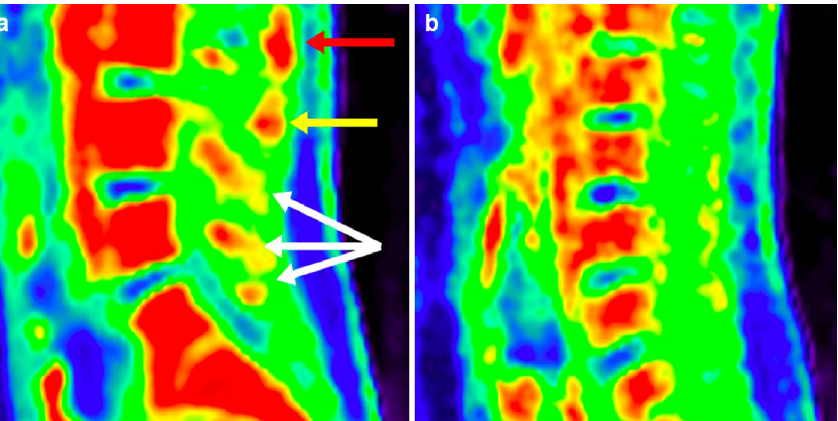
Figure 3. Increased spinal uptake of [18]F-FDG in patient with suspected cerebrospinal fluid leak. Sagittal PET of patient with suspected CSF leak ( a ) shows areas of increased tracer uptake in the region of the interspinous ligament between L1 and L2 (red arrow, SUV max = 2.90), in the region of the interspinous ligament between L2 and L3 (yellow arrow, SUV max = 2.14), and in the area between the spinal cord and vertebral arch of the lower lumbar vertebrae (white arrows, SUV max at L3 = 2.02, SUV max at L4 = 2.22). By comparison, sagittal PET of a healthy control ( b ) at the same level does not show increased uptake in these regions (Mean SUV max between L1 and L2 = 1.23, between L2 and L3 = 1.23, at L3 = 0.98, at L4 = 0.98 for controls). This patient underwent paramedian interlaminar blood patching at L1-2 and L2-3, left transforaminal blood patching at L1-2 and L2-3, and right paramedian caudal fibrin blood patching following the PET/MRI study. The patient reported these patches made him feel better for a week, unlike previous patches that had provided no relief at all.